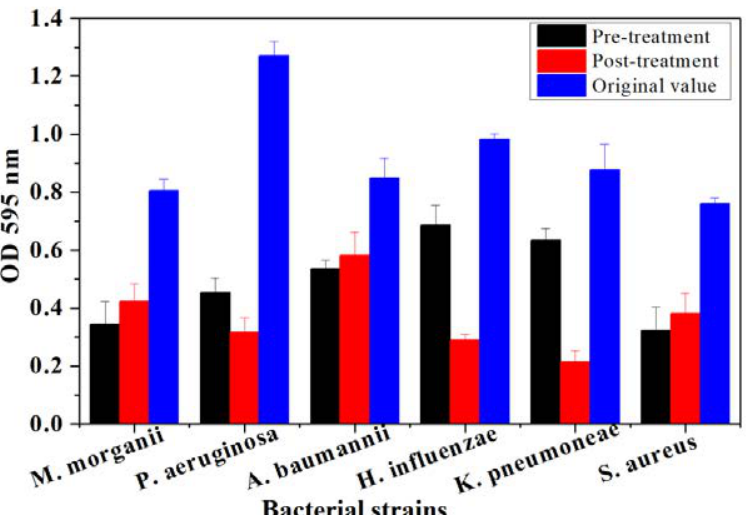
Fig. 1. Comparative analysis of biofilm growth of six bacterial strains on a microtiter plate before and after pre and post treatment by Juglans regia bark. At the end of 72-h controlled incubation, the biofilm formation was quantified via staining with crystal violet. Following staining, the spectrophotometric absorbances were recorded at OD Bars represent means ± standard errors for three replicates.